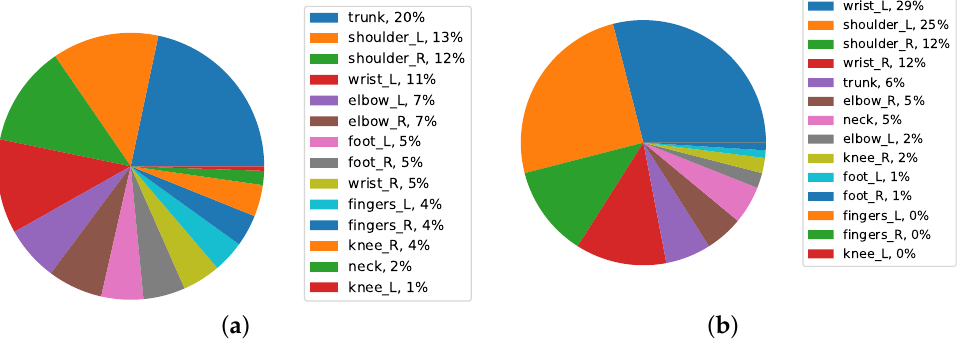
Figure 15. Average FWA of body parts in Body Construction for ( a ) and ( b ) Metal Stamping data.